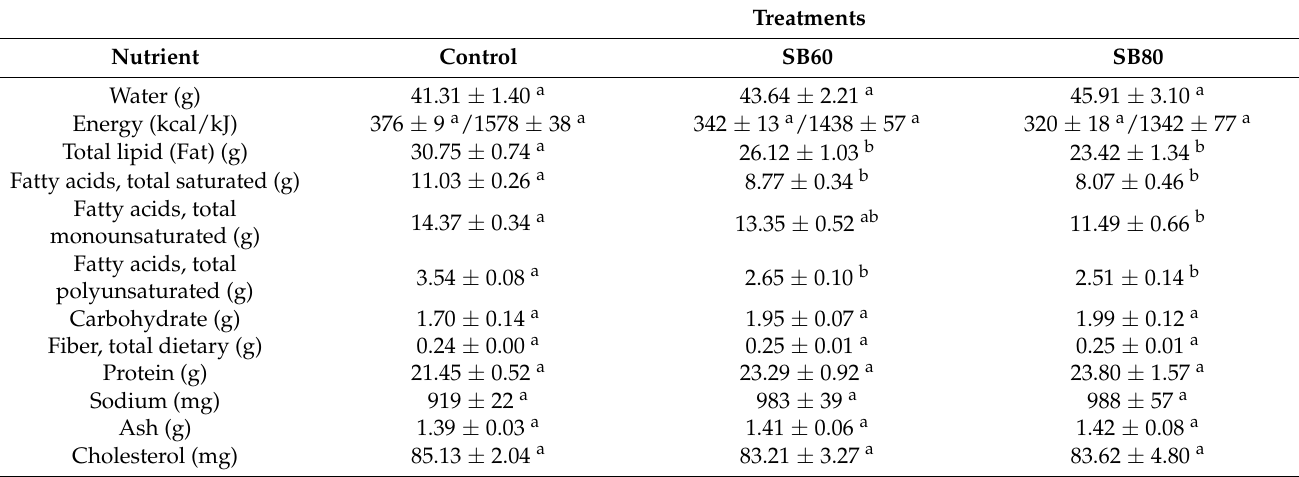
Table 1. Nutritional composition and changes in the energy, fatty acids, cholesterol, and protein of uncooked fermented sausages per 100 g.